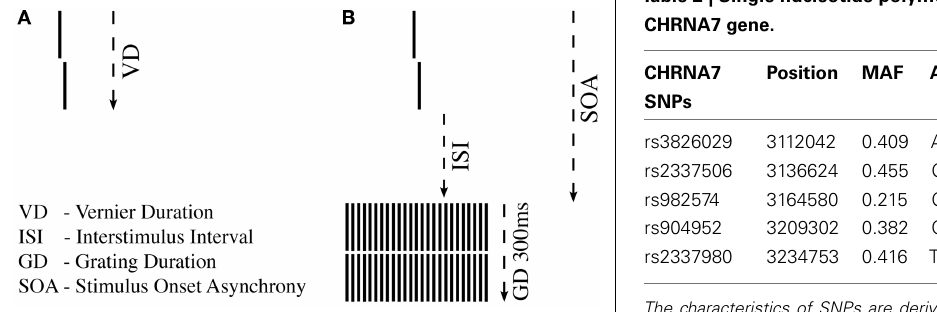
Table 2 | Single nucleotide polymorphisms genotyped within